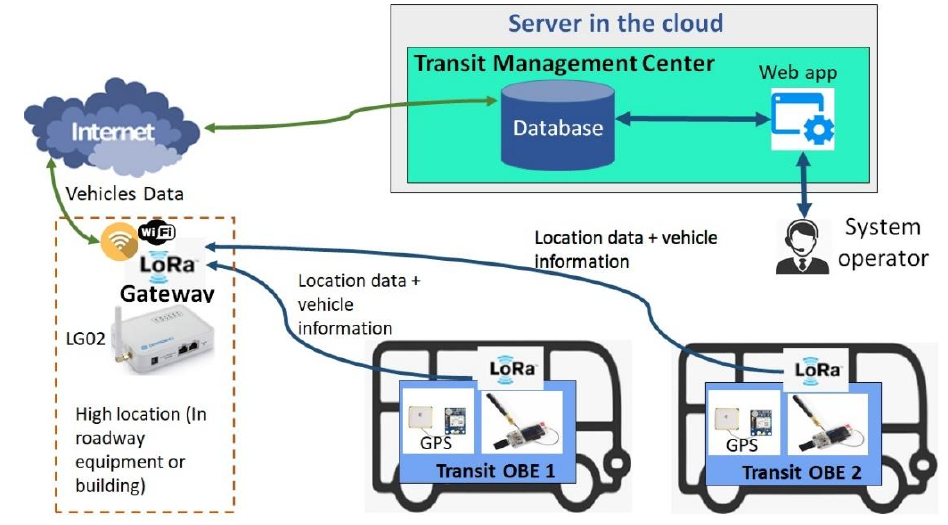
Figure 2. Transit vehicle tracking service prototype.